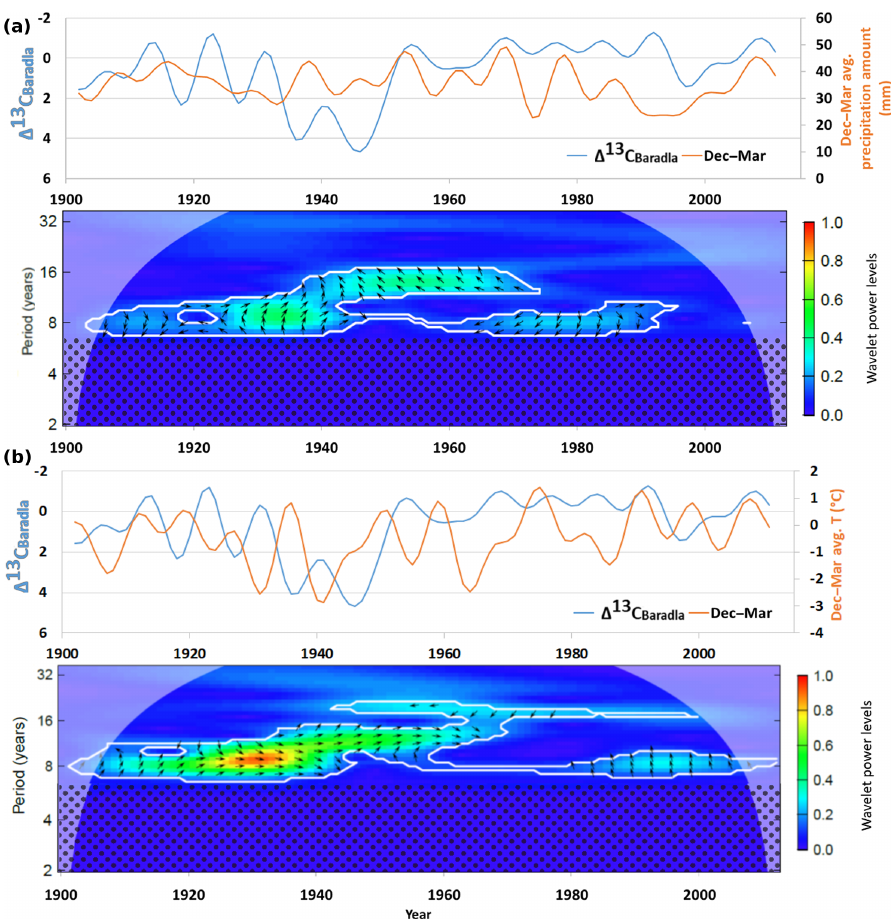
Figure 4. Time series of the 7.5-year low-passed composite (cid:49) 13 C Baradla records (on a reversed axis) with the gridded December–March average (a) temperature and (b) precipitation amount (Harris et al., 2014) (upper panel) and their time–frequency coherency image (lower panel). The white contours in the lower panel show the 90% confidence levels calculated based on 1000 AR(1) surrogates. The black arrows indicate the phase-angle difference, where an in-phase relationship is indicated by arrows pointing to the right, whereas anti-phase relationship is shown by arrows pointing to the left. The dotted area marks the period band below the cut-off